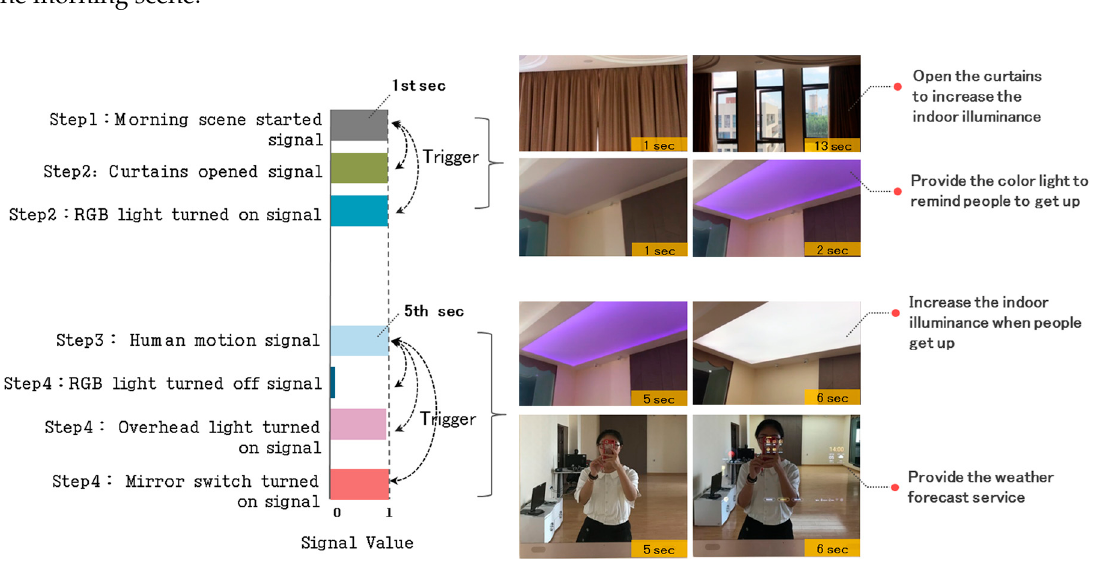
Figure 10. Collaborative control process of multiple sensors and devices.